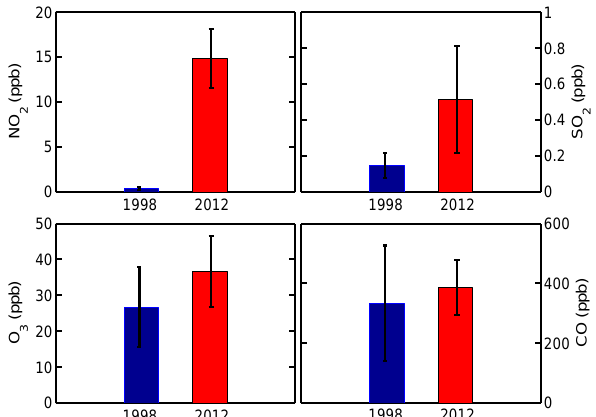
Figure 6. Comparisons of the average mixing ratios (bars) of NO 2 , SO 2 , O 3 , and CO during June and September between 1998 and 2012. The black line gives the standard deviation.